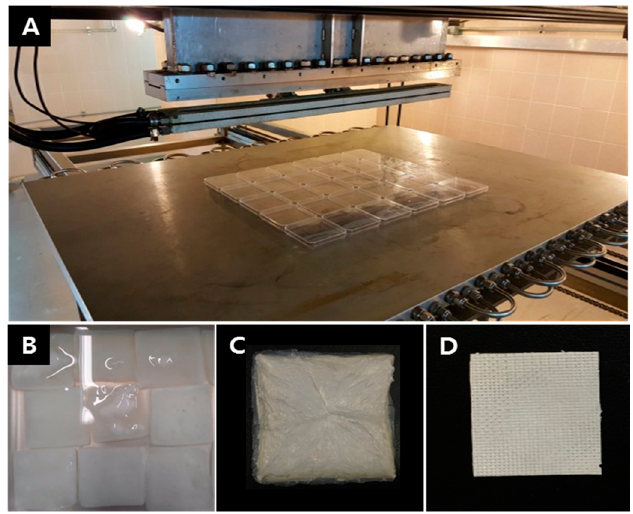
Figure 10. ( A ) Electron beam linear accelerator (Korean Atomic Energy Research Institute, Jeongeup,